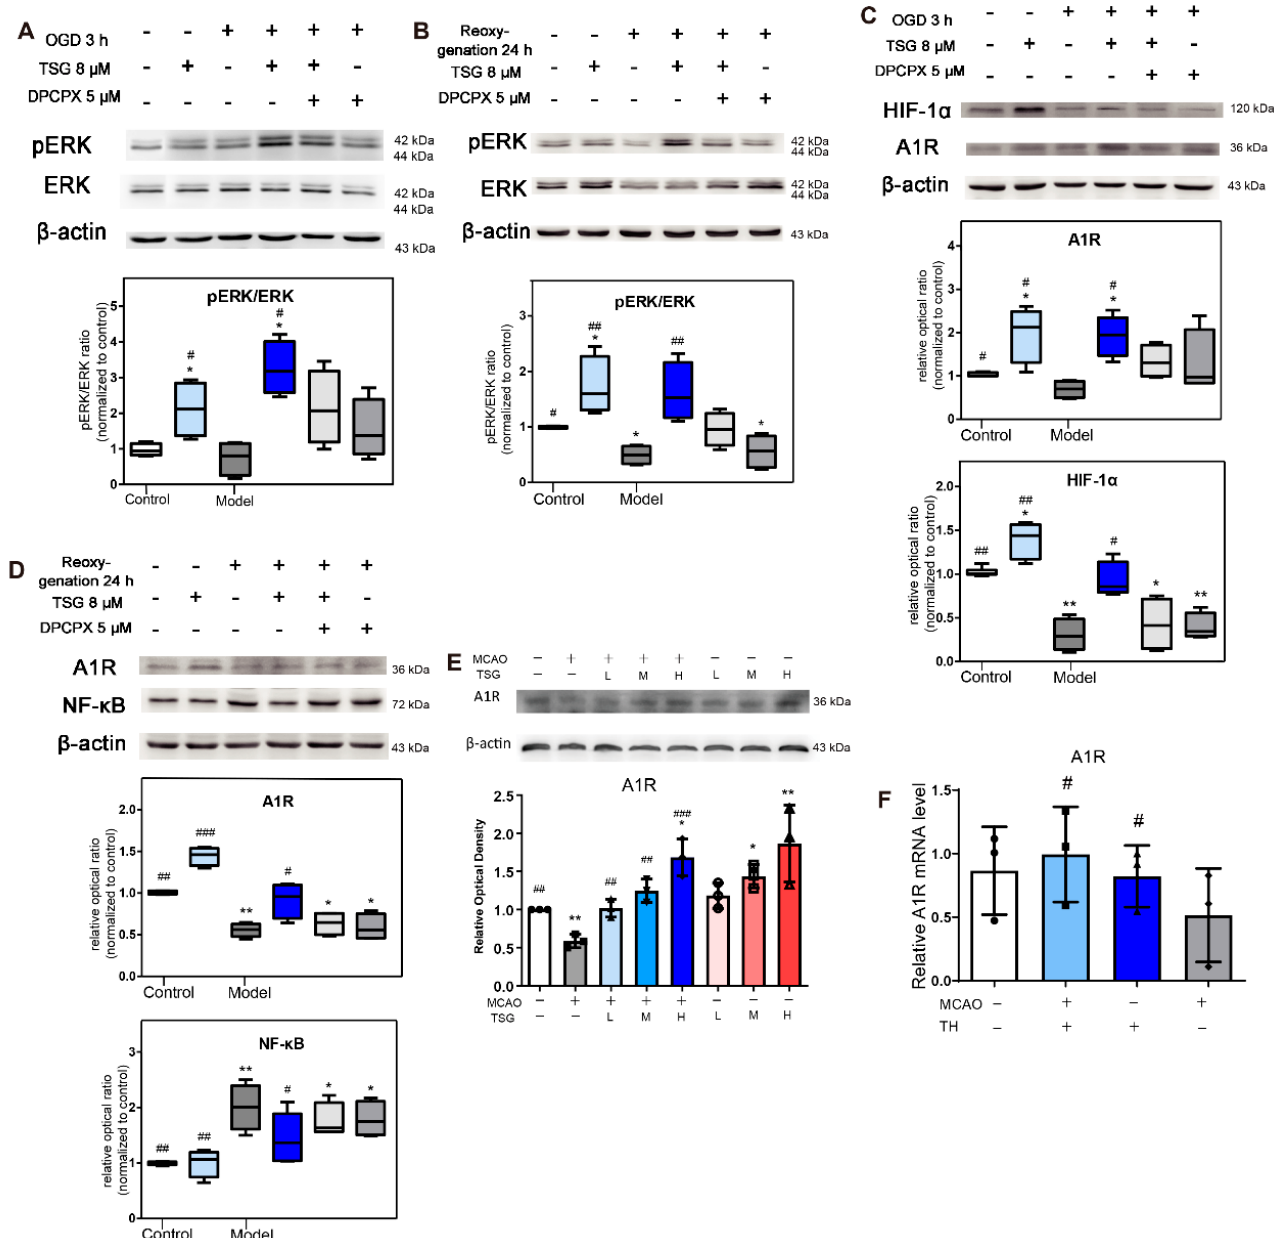
Figure 7. Effects of TSG on the expression of HIF-1 α , A1R, NF- κ B, ERK1/2 and pERK1/2 in OGD cells. ( A,B ) The expression of ERK1/2 and pERK1/2 in SH-SY5Y cells harvested after OGD 3 h and OGD/R (3 h/24 h) and the relative intensity ratio of pERK/ERK ( n = 4). ( C ) The expression of A1R, HIF-1 α in SH-SY5Y cells harvested after OGD ( n = 4). ( D ) The expression of A1R, NF- κ B in SH-SY5Y cells harvested after OGD/R ( n = 4). ( E ) The expression of A1R in rats of each group ( n = 3). ( F ) The gene expression levels of A1R affected by MCAO and TSG in brains by Q-RT-PCR in each group ( n = 3). The relative intensity was analyzed with ImageJ software and calculated by the ratio relative to the β -actin intensity. # p < 0.05, ## p < 0.01, and ### p < 0.001, other groups vs. the model, OGD or OGD/R groups; * p < 0.05, ** p < 0.01, other groups vs. the control group.